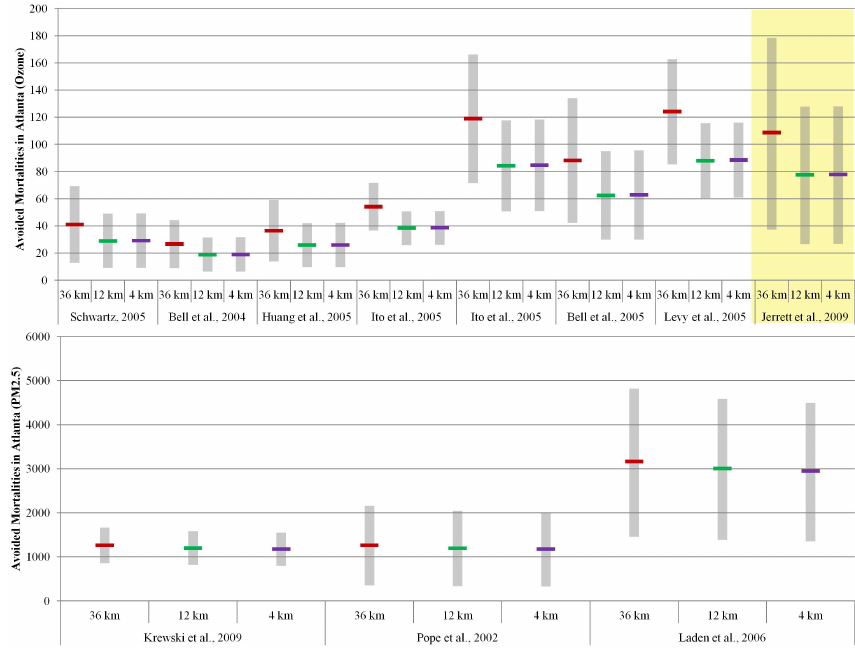
Fig. 3. (a) Mortalities avoided due to changes in ozone concentrations between the 2005 base case and the 2014 control case for each model resolution (red indicates 36km, green 12km, blue 4km), calculated using eight different concentration–response functions. The rightmost CRF result, highlighted in yellow, represents estimates for long-term effects of ozone exposure. All other ozone CRF results represent short- term effects. (b) Mortalities avoided due to changes in PM 2 . 5 concentrations between the 2005 base case and the 2014 control case for each model resolution (red indicates 36km, green 12km, blue 4km), calculated using three different concentration–response functions (CRFs). All PM 2 . 5 CRFs represent estimates for long-term effects of PM 2 . 5